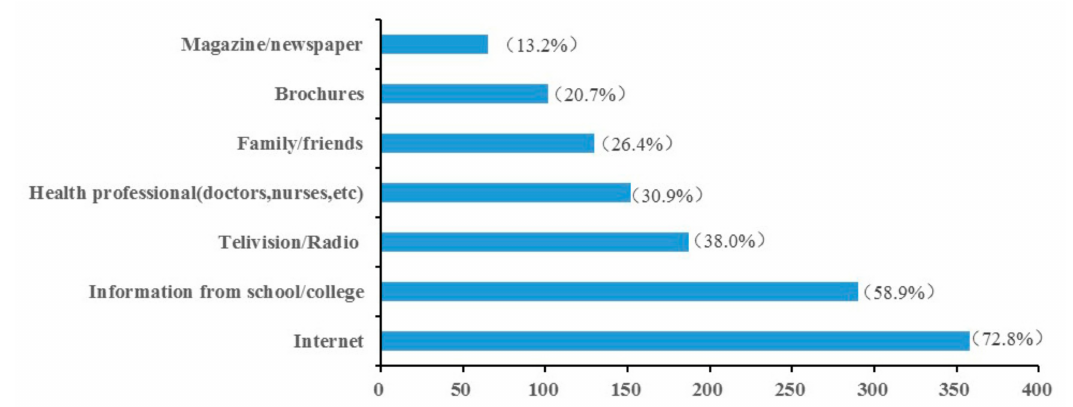
Figure 1. The sources of information the participants achieved for those who have heard HPV (Human